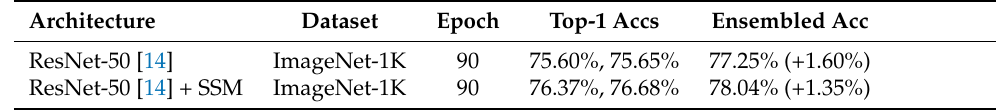
Table 3. Results of ensemble classification in